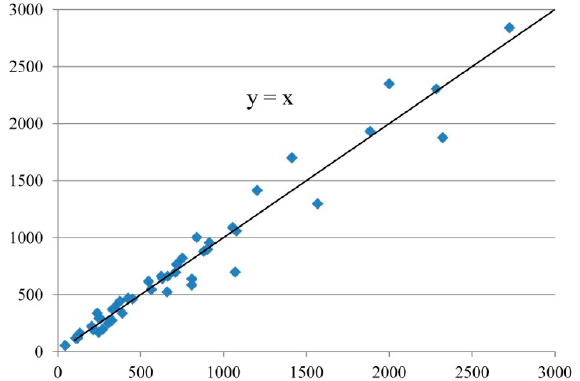
Figure 6. Comparison of urban extent (in number of 1-km resolution urban pixels) from VANUI and urban areas form USGS NLCD land cover product with linear regression in metropolitan areas in the Southeast U.S.A.